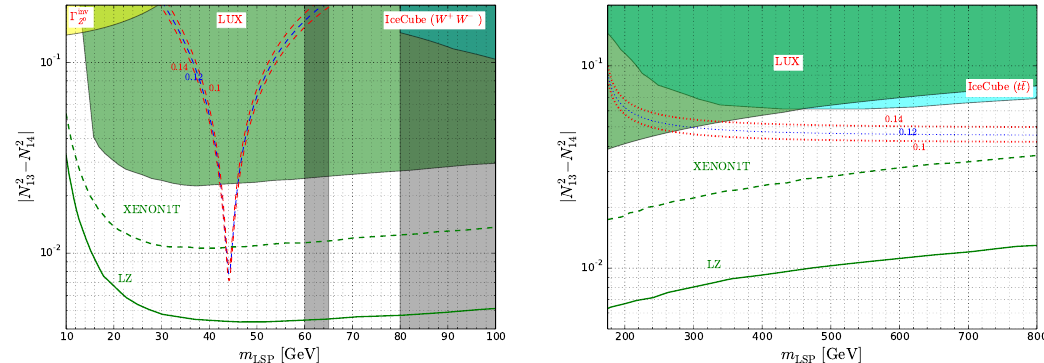
(cid:0) N 2 j for two 13 14